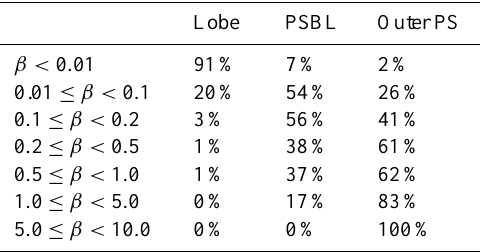
Table 1. A percentage of the lobe, PSBL and outer PS samples for particular ranges of plasma β values. Lobe PSBL Outer